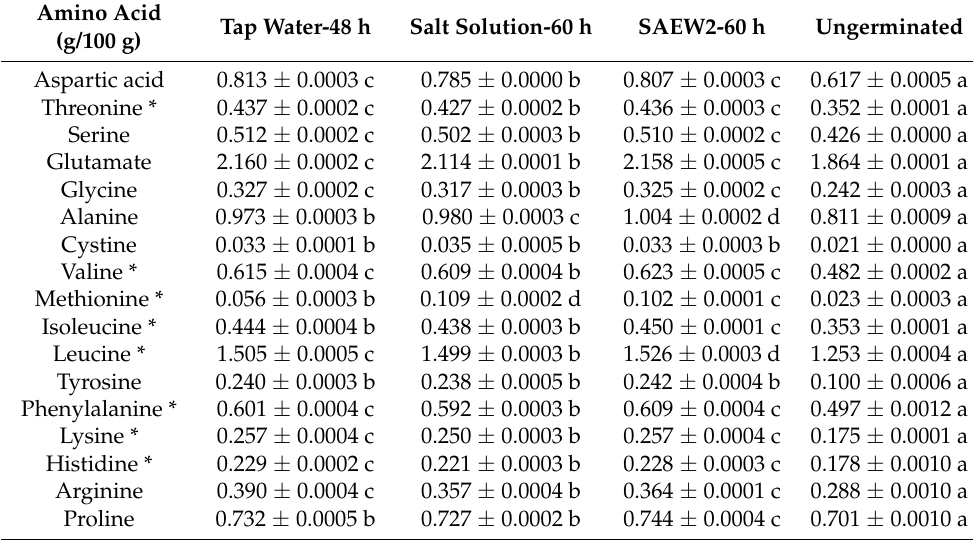
Table 4. Amino acid profiles of different germinated foxtail millet treaments 1 . Amino Acid Tap Water-48 (g/100 g)